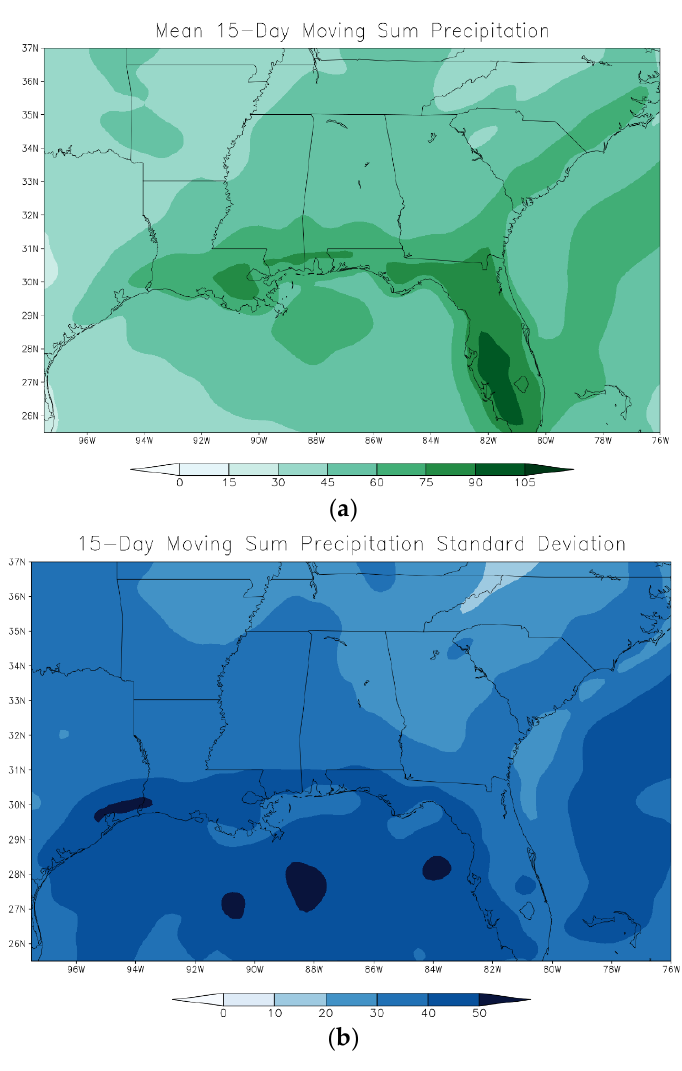
Figure 2. Mean precipitation (mm — panel a ) and precipitation standard deviation (mm — panel b ) for all 15-day moving sum data for the study domain.